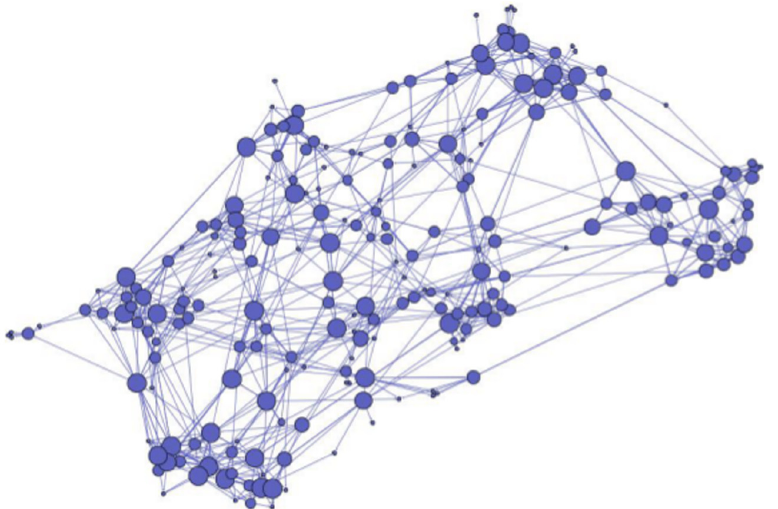
Fig 1. Study 2: Network representing out-degree (i.e., the number of friends a participant claimed) for Year 11 participants at a boys ’ school in Australia. Note . Every participant is represented as a node and the size of the node represents the number of friends that were listed by participants. Connections between nodes indicate interpersonal ties. N = 161.